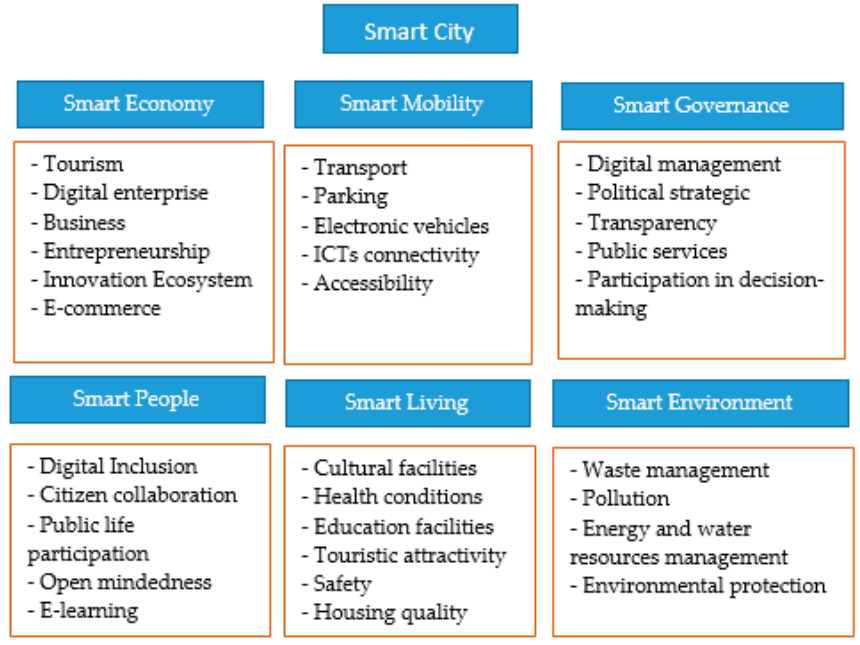
Figure 1. Dimensions in the development of an effective smart city model [10].